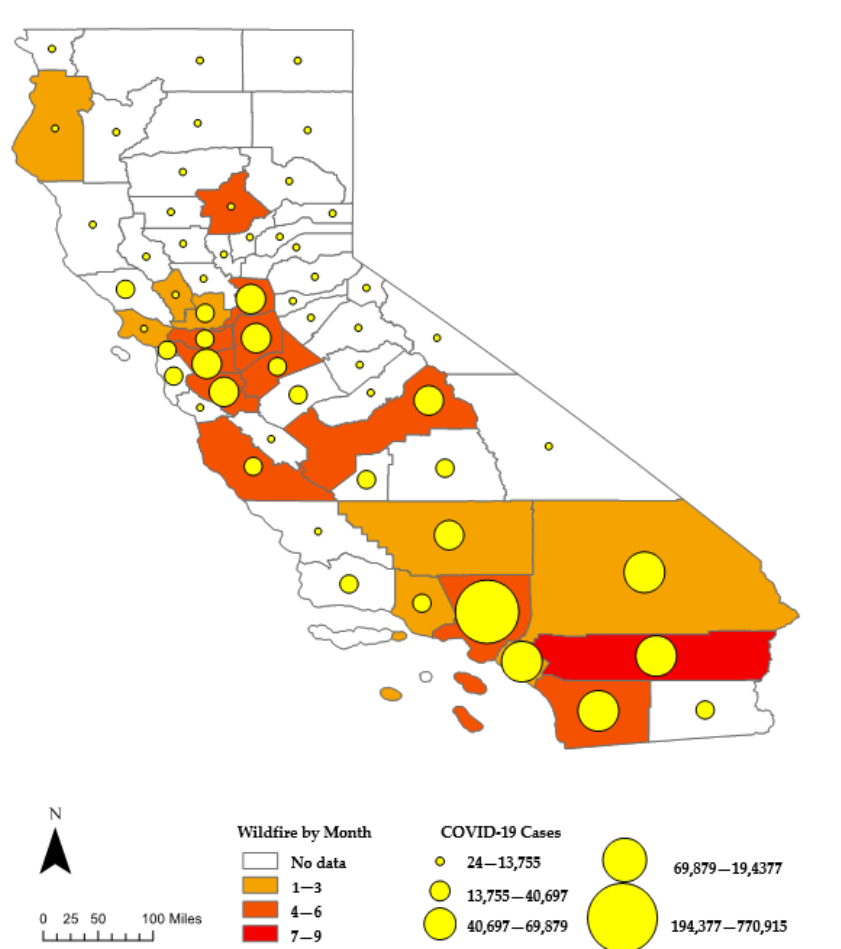
Figure 1. Locations of the 20 counties and cumulative COVID-19 cases in each as of 31 December 2020.